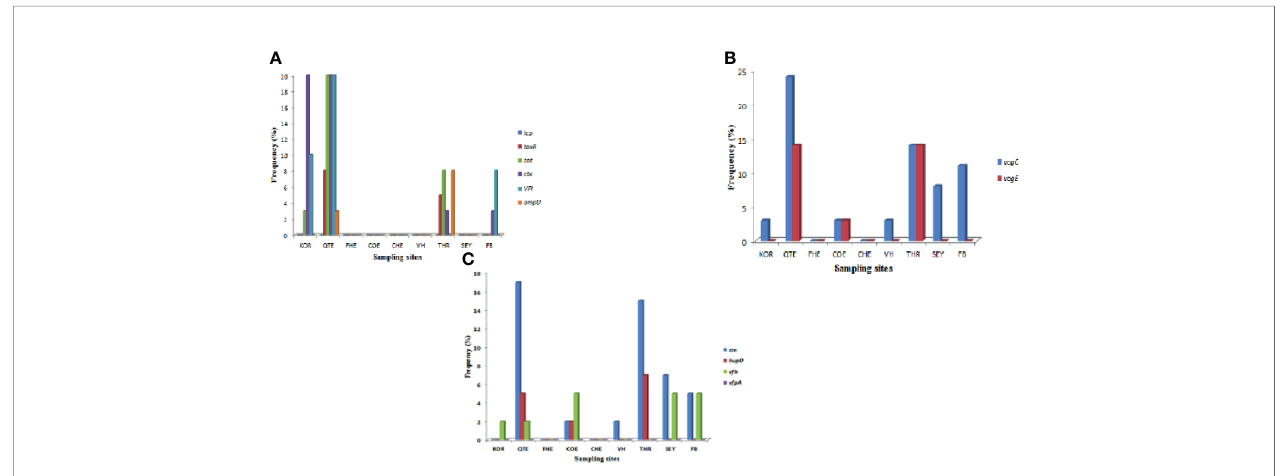
FIGURE 3 | (A) = Frequency of V. mimicus virulence gene from all sampling sites, (B) = Frequency of V. vulni fi cus virulence genes from all sampling sites and (C) is Frequency of V. fl uvialis virulence genes from all sampling